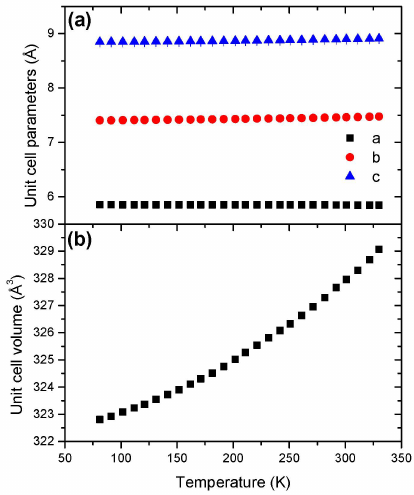
Figure 8. Temperature dependence of ( a ) the unit cell parameters and ( b ) the unit cell volume for LiHB in the temperature range 81–330 K.